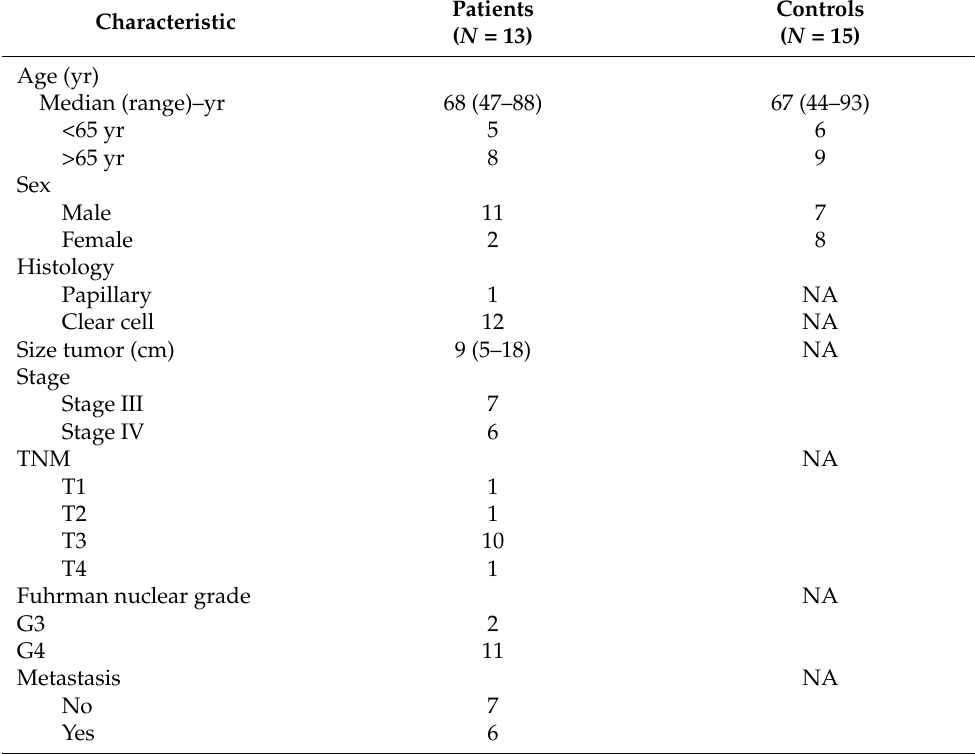
Table 1. Characteristics of the study population.